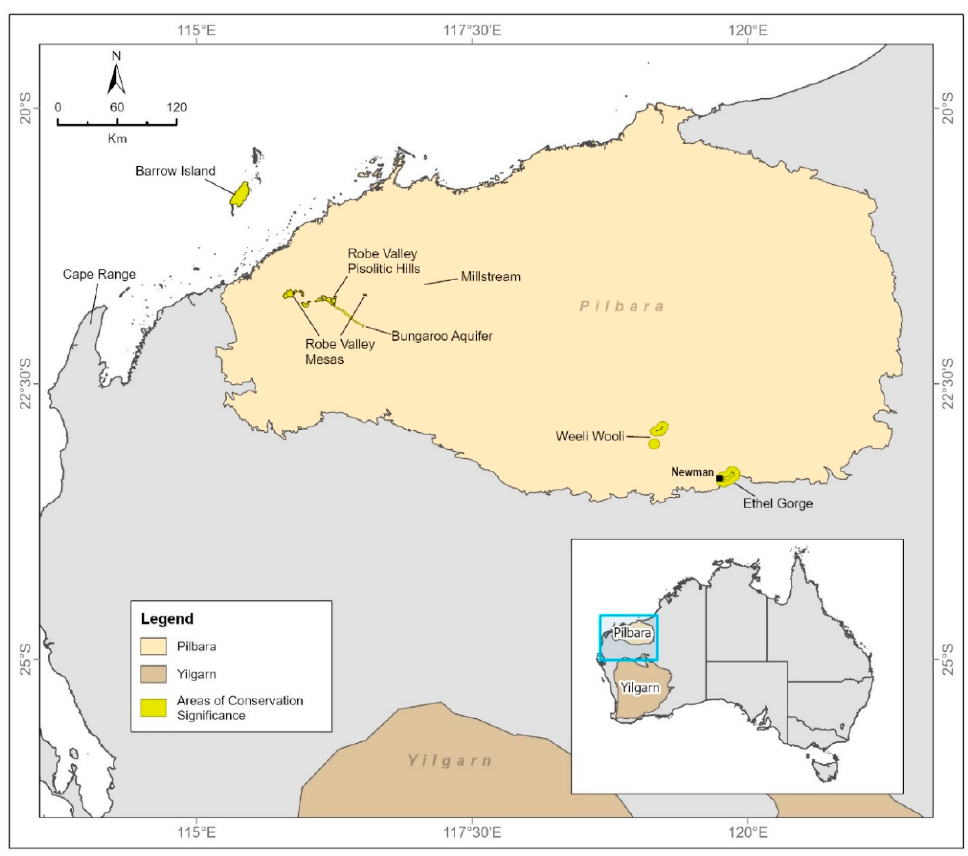
Figure 1. The Pilbara region of Western Australia, showing subterranean fauna communities recog- nized as significant for conservation. The Robe Valley hotspot is at the western end of the Robe Valley Pisolitic Hills.